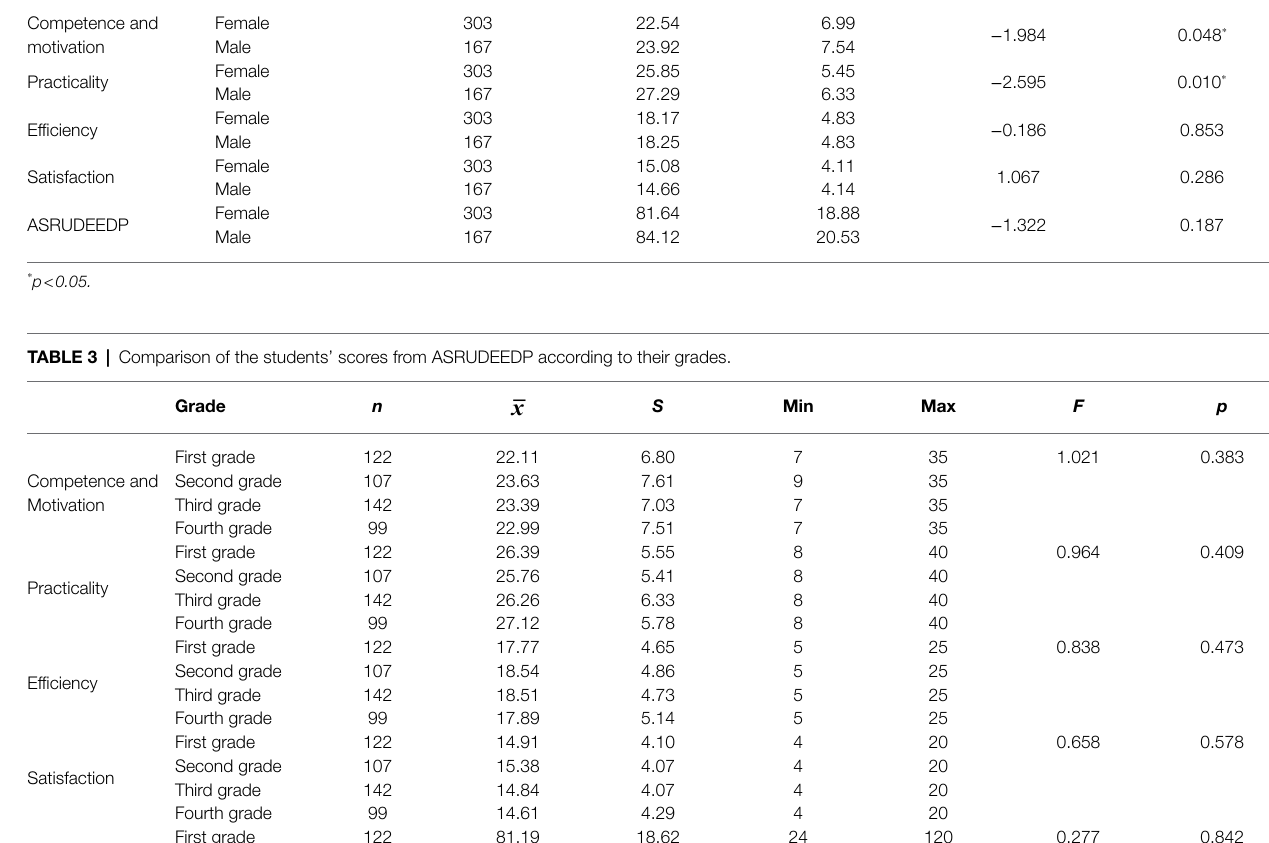
TABLE 2 | Comparison of the students’ scores from ASRUDEEDP according to their gender. Gender N